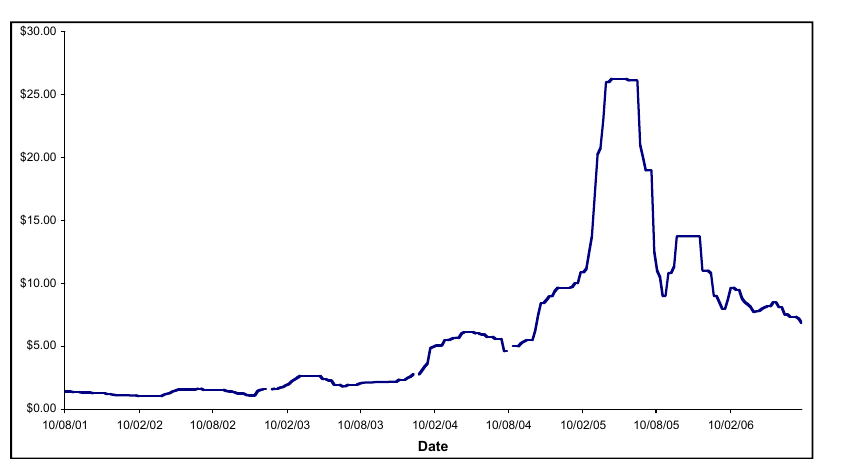
Figure 6. Vanadium pentoxide prices, 10 August 2001–4 August 2006